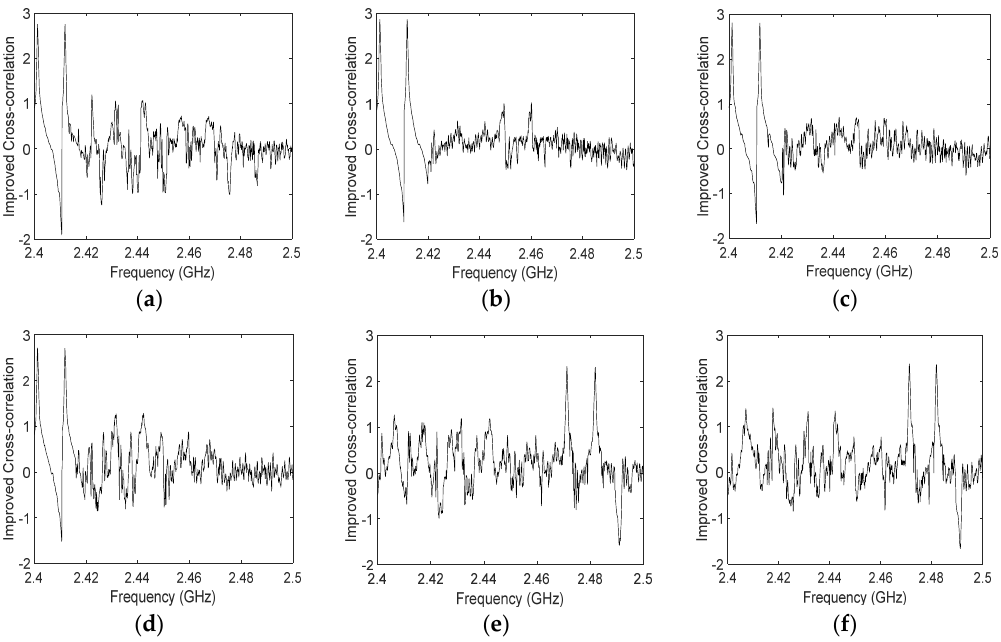
Figure 9. The frequency estimation results using the proposed method outdoors at distances of ( a )